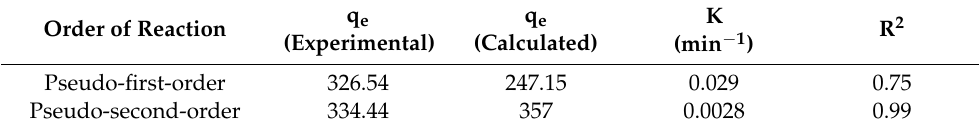
Table 1. Kinetic parameters for ODS of model oil in the presence of MnO 2 /MrGO catalysts.